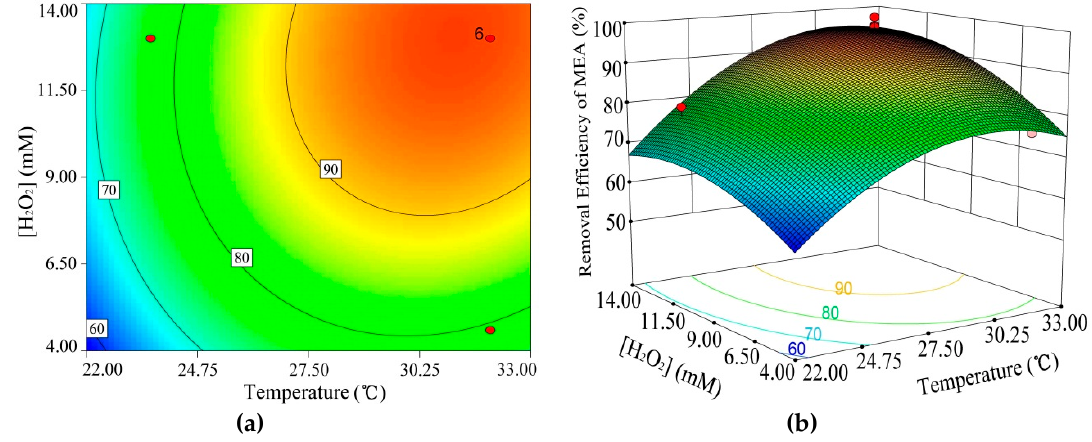
Figure 6. Response surface plots for the temperature and [H 2 O 2 ] at pH = 4.30. ( a ) Contour, ( b ) 3D surface.